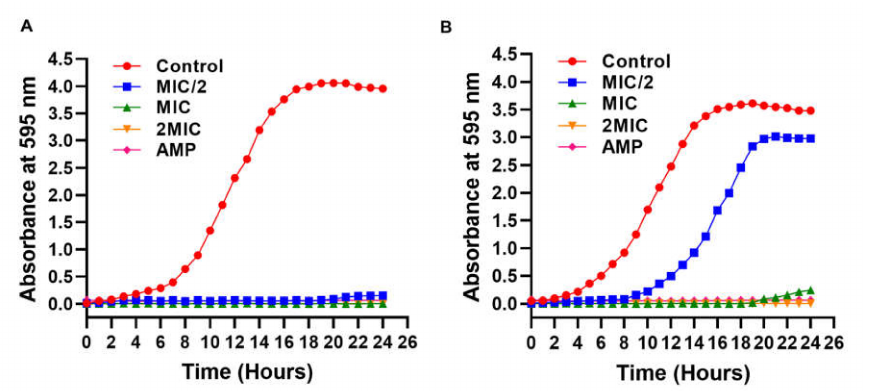
Figure 4. Growth kinetics study of ( A ) E. coli , ( B ) P. aeruginosa at different MIC concentrations of PIP. Ampicillin (AMP) was taken as a positive